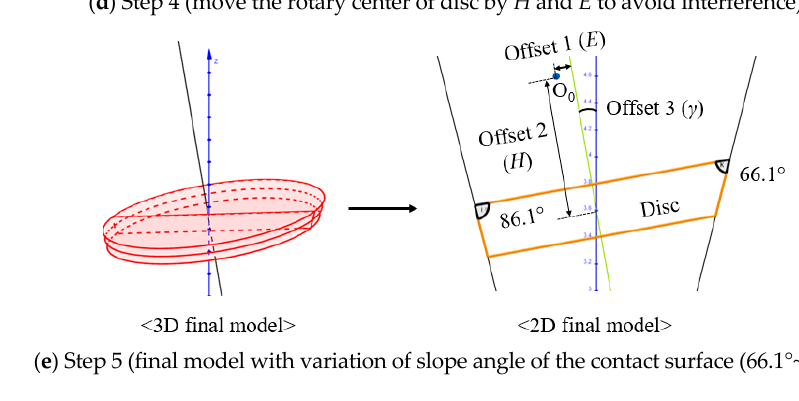
Figure 9. Procedure for generation of slope angle of the contact surface. Table 1. The value of triple offset butterfly valve (TOBV) parameters.